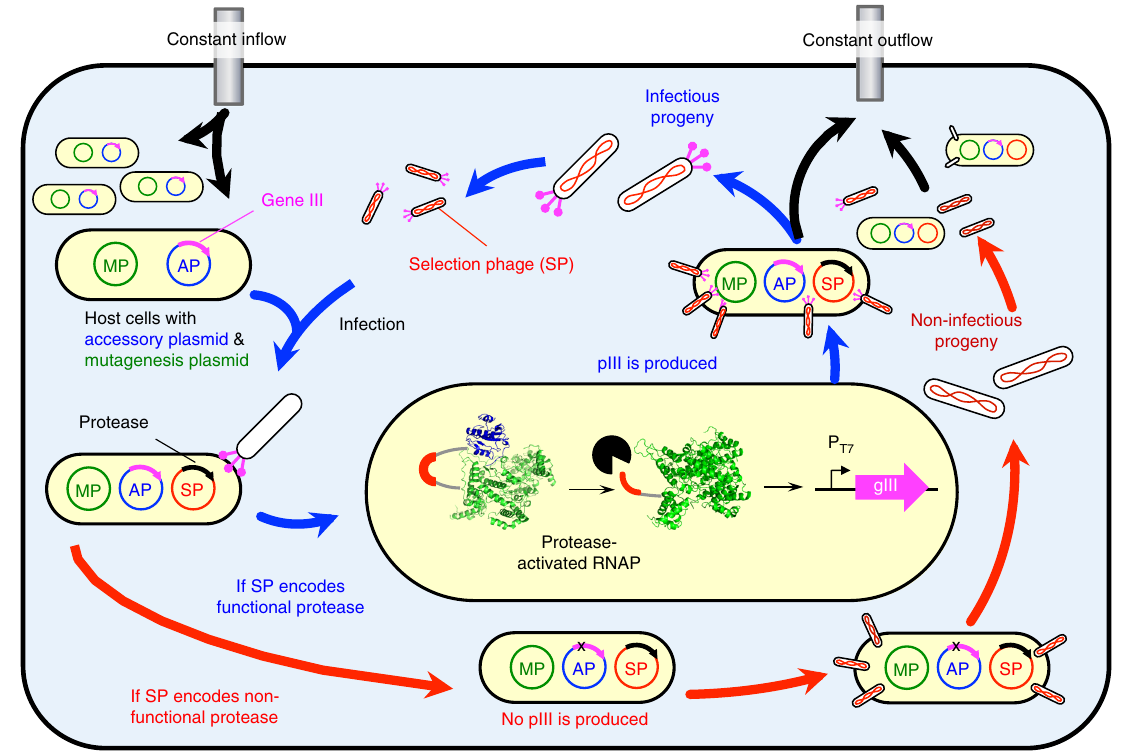
Fig. 1 Overview of protease PACE. A culture of host E. coli continuously dilutes a fi xed-volume vessel containing an evolving population of selection phage (SP) in which essential phage gIII has been replaced by a protease gene. These host cells contain an arabinose-inducible mutagenesis plasmid (MP) and an accessory plasmid (AP) that supplies gIII. The expression of gIII is made protease-dependent through the use of a protease-activated RNA polymerase (PA-RNAP) consisting of T7 RNA polymerase fused through a cleavable substrate linker to T7 lysozyme, a natural inhibitor of T7 RNAP transcription. If an SP encodes a protease capable of cleaving the substrate linker, then the resulting liberation of T7 RNAP leads to the production of pIII and infectious progeny phage encoding active proteases. Conversely, SP encoding proteases that cannot cleave the PA-RNAP yield non-infectious progeny